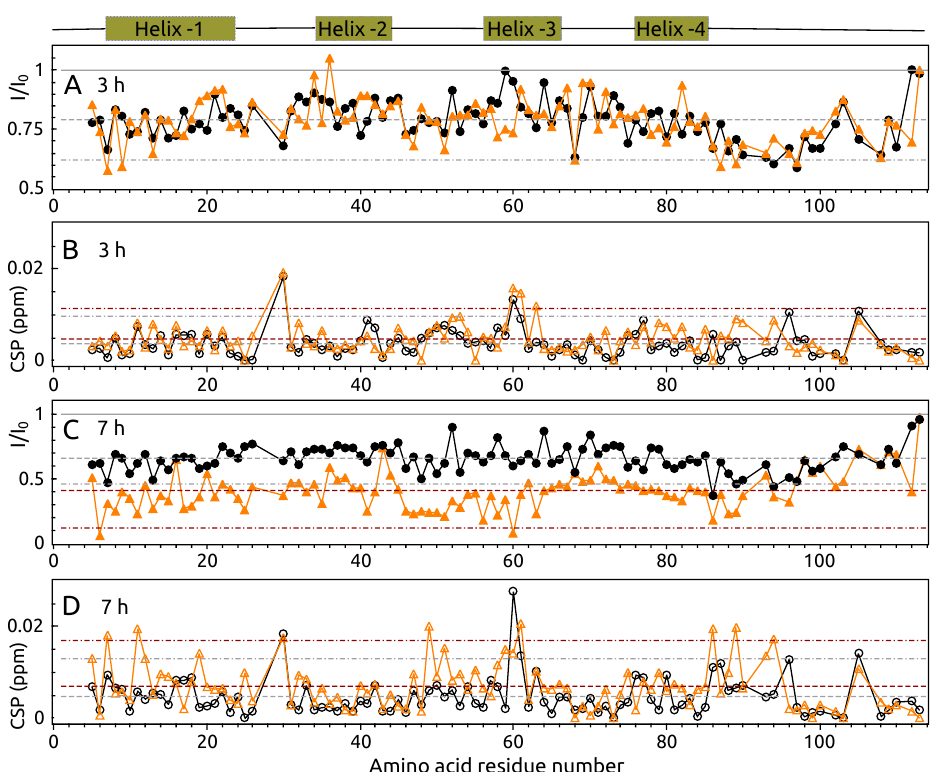
Figure 7. ( A , C ) Intensity and ( B , D ) chemical shift change of S100A9 peaks in 15 N– 1 H HSQC spectra after incubation at 37 ◦ C, 250 RPM for 3 h ( A , B ) and 7 h ( C , D ) in the absence (black) or presence (orange) of α -syn. The schematic secondary structure of S100A9 is shown above. Solid gray line in ( A , C ) is the intensity of S100A9 before aggregation started (I 0 ). I is the intensity after 1 h or 3 h of aggregation. The average of intensity or a chemical shift perturbation are shown by a dashed line, mean plus two standard deviations—dot dash line (gray color for sample S100A9 and wine for S100A9- α -syn ). Protein solution: 100µM 15 N S100A9, 0 or 100µM α -syn, 25mM HEPES, 100mM NaCl, 1mM DTT, 1mM CaCl 2 , 5% D 2 O, 0.02% sodium azide, pH